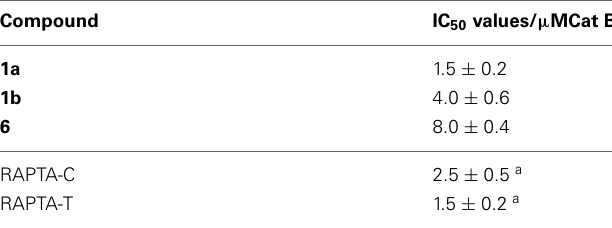
Table 2 | IC 50 ( μ M) of 1a, 1b, RAPTA-C, and RAPTA-T against bovine cat